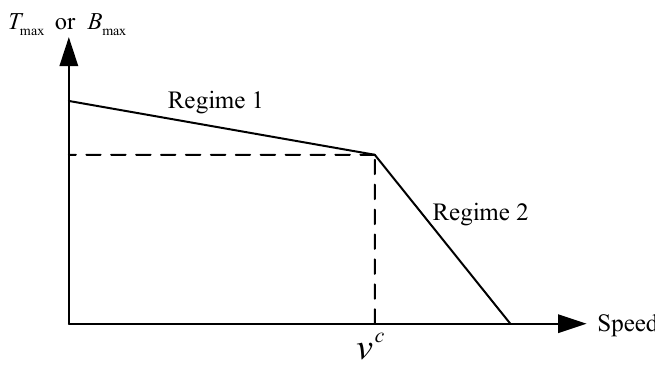
Figure 1. Example of the maximum tractive or maximum braking force.